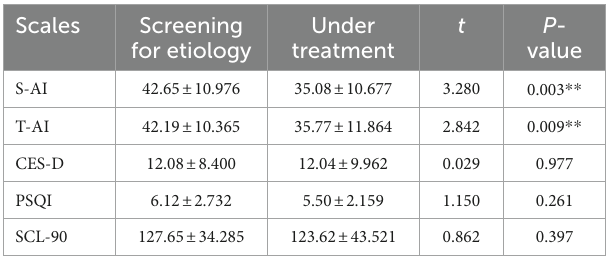
TABLE 3 Comparison of levels of anxiety and depression at different diagnosis and treatment stages in recurrent pregnancy loss (RPL) women ( n = 25).